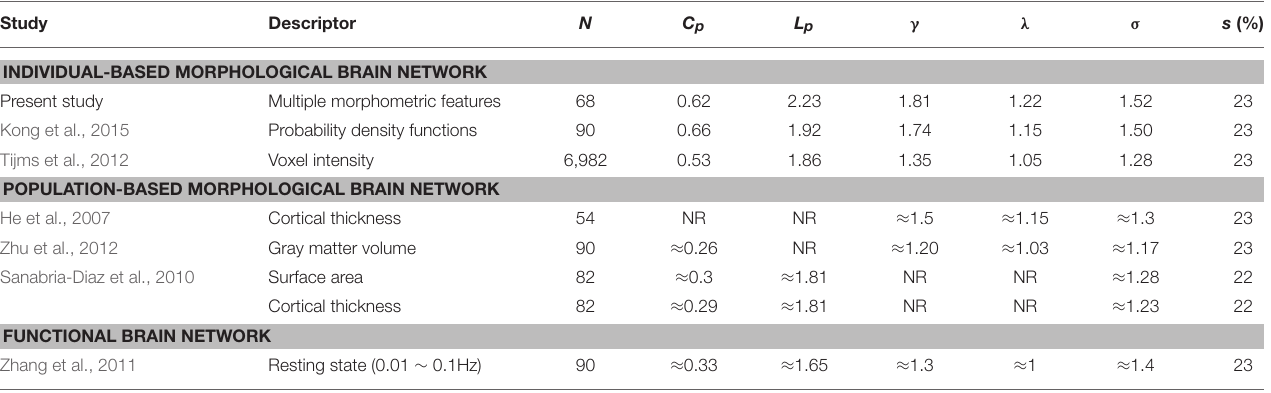
TABLE 1 | Comparison of small world configurations between the present study and previous studies.